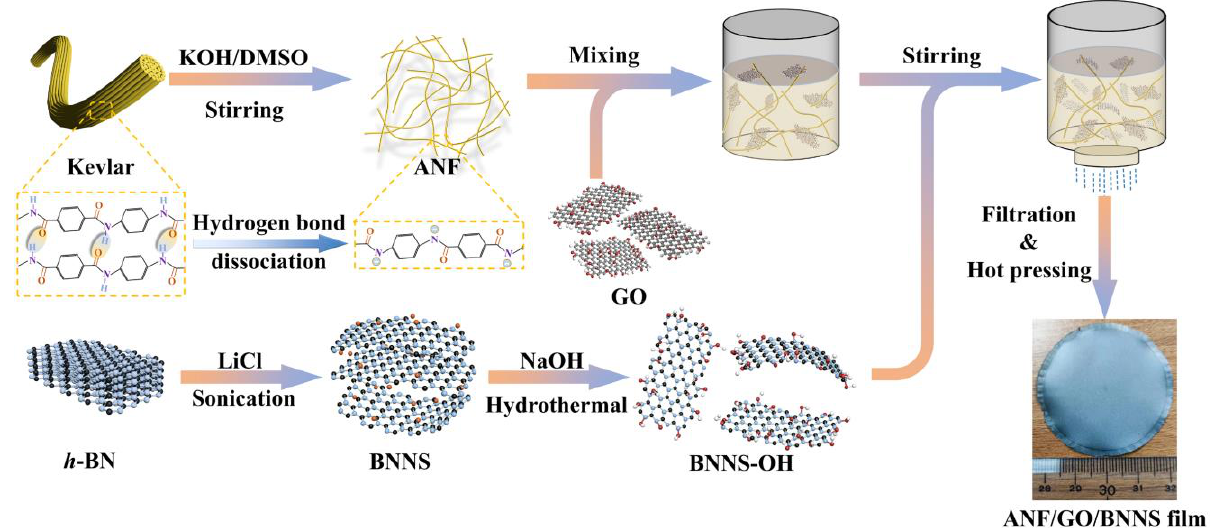
Figure 1. Schematic illustration for fabrication of the ANF/GO/BNNS composite film. The ANF/GO/BNNS composite film was fabricated by simple vacuum-assisted fil- tration of the uniformly distributed ANFs, GO sheets, and BNNS-OH mixture dispersion, and followed by a hot-pressing process. Briefly, 10 mg GO sheets and 10 mg BNNS-OH were dispersed uniformly in DMSO solvent, respectively. 46 g DMSO solvent was added to 23 g ANFs/DMSO solution (100 mg ANFs) to dilution, and then 4% deionized water (2.76 g) was added to the diluted solution, then sonicated (500 W) in a bath for 1 h to partial protonation of ANFs. Then the GO/DMSO solution was added to the treated ANFs/DMSO solution and stirred magnetically at 800 rpm for 1 h at 25 ◦ C, then the uniformly dispersed BNNS/DMSO solution was added, and magnetic stirring was continued at 25 ◦ C for 2 h. The obtained ANF/GO/BNNS/DMSO dispersion was injected into 500 mL of H 2 O to form the colloidal ANF/GO/BNNS. Then, the colloidal ANF/GO/BNNS was separated by vacuum filtration using Buchner funnel to completely remove the residual DMSO and KOH until the filtrate is neutral. The purified colloidal ANF/GO/BNNS was added to 400 mL of H 2 O and violently cut at 14,000 rpm for 10 min to obtain a uniform ANF/GO/BNNS slurry. Then, the slurry was continuously vacuum-filtrated with a 0.2- µ m-pore polytetraflu- oroethylene (PTFE) membrane for over 8 h to obtain the ANF/GO/BNNS film, which was hot-pressed at 150 ◦ C for 5 min and vacuum-dried at 45 ◦ C for 48 h. Here the fabricated composite film was composed of 10 mg GO, 10 mg BNNS-OH, and 100 mg ANFs, and was labeled ANF/GO-10/BNNS-10. The preparation of other ANF/GO/BNNS composite films only needs to change the mass of BNNS and GO, and the steps remain the